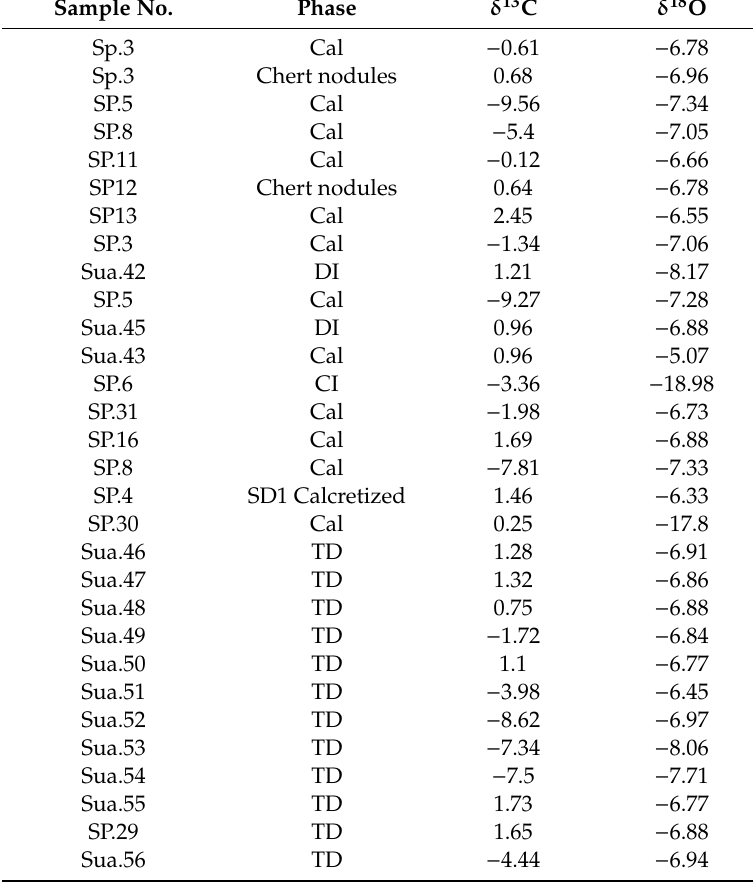
Table 1. δ 18 O VPDB and δ 13 C VPDB isotopic composition values (% (cid:24) ), where Cal = calcrete, DI = matrix dolomite, CI = blocky calcite, SD1 = saddle dolomite, and TD = tidal